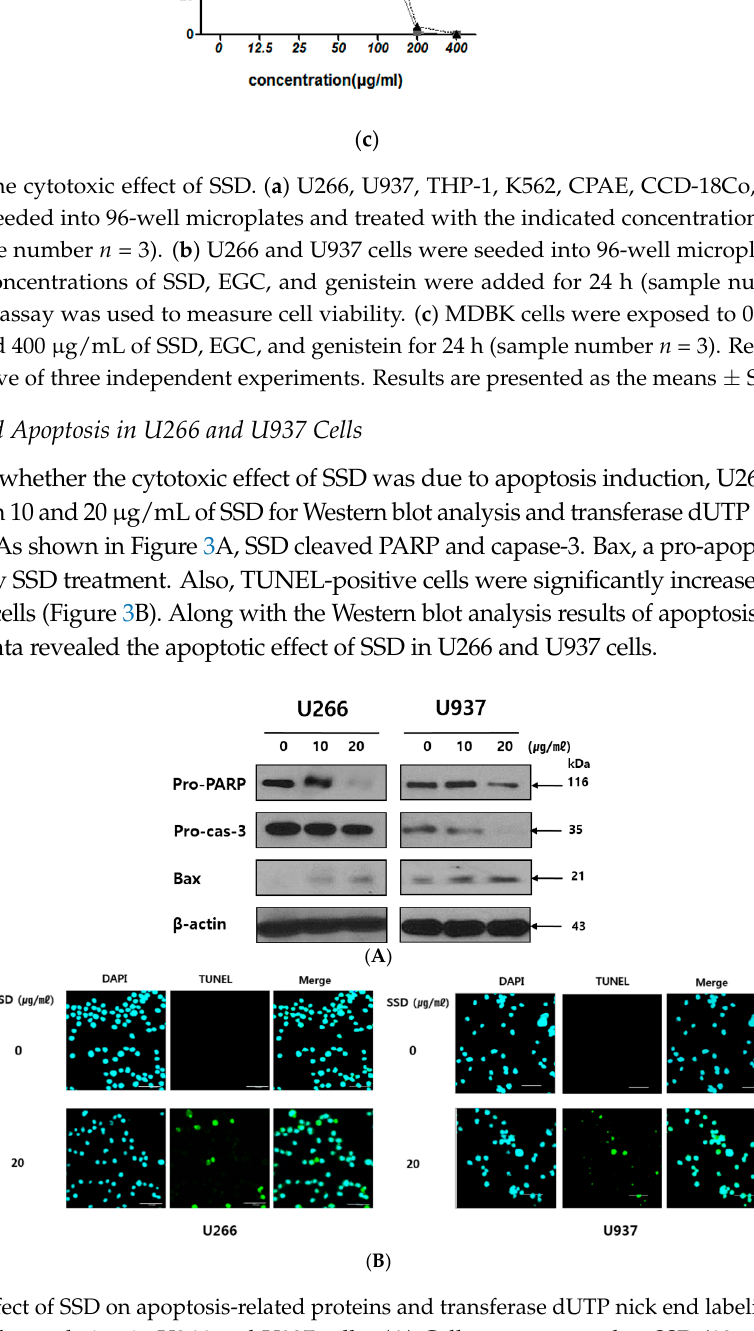
Figure 3. Effect of SSD on apoptosis-related proteins and transferase dUTP nick end labeling (TUNEL) -positive cell population in U266 and U937 cells. ( A ) Cells were exposed to SSD (10 or 20 µ g/mL) for 24 h. The lysates were subjected to Western blot analysis for pro-PARP, pro-caspase-3, Bax, and β -actin. ( B ) Cells were treated with 20 µ g/mL of SSD and used for TdT-mediated dUTP nick end labeling (TUNEL) staining (sample number n = 3). Scale bar: 50 µ m. Cells were